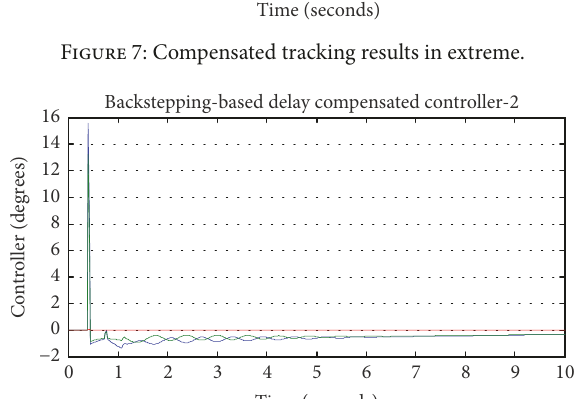
Figure 8: Compensated actuator deflections in extreme.